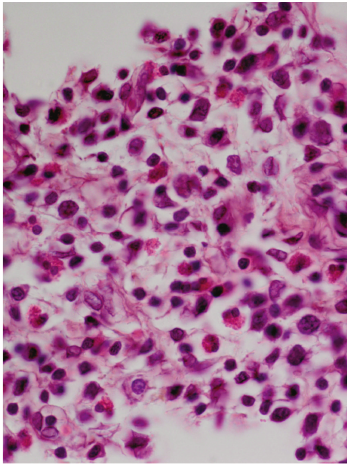
Figure 2: Section of stomach of rabbit showing a juvenile A. strongylina longitudinally cut deep into the mucosa. Arrow indicates head end of the L 4 (H. E. original magnification × 100X).